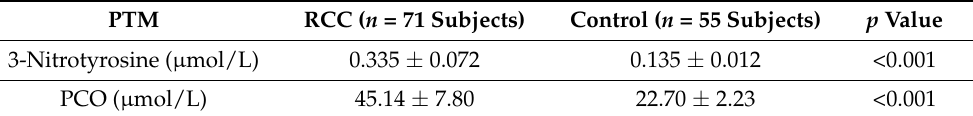
Table 2. Protein nitration and carbonylation status in the studied